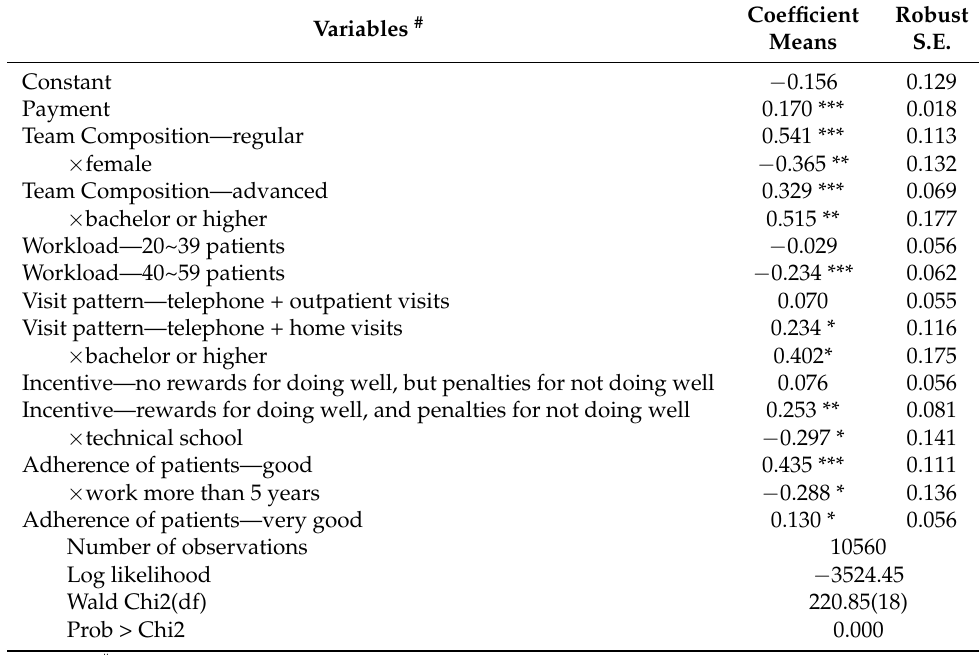
Table 4. Analysis with interaction